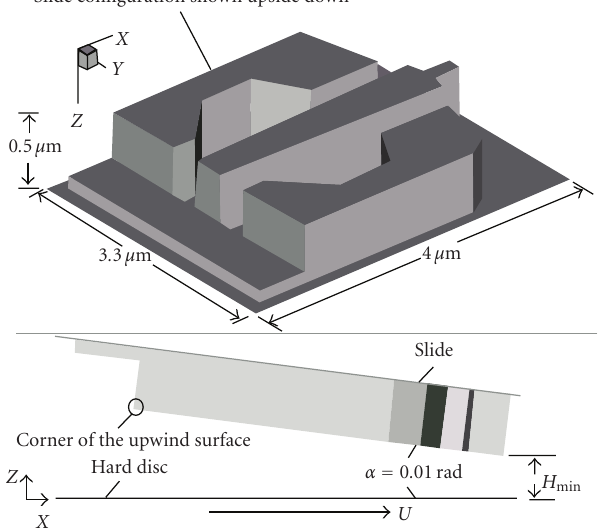
Figure 9: Configuration of a slider used in simulation in [37], slightly modified from that of [10].